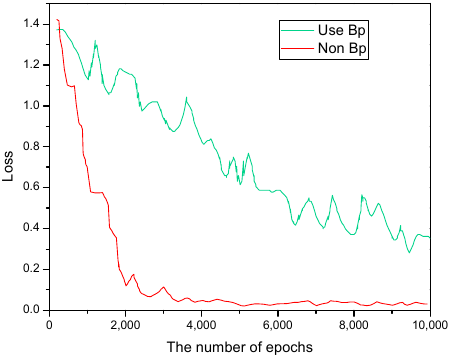
Figure 4. Accuracy curve: comparison of proposed non-BP and BP algorithm in the training process.